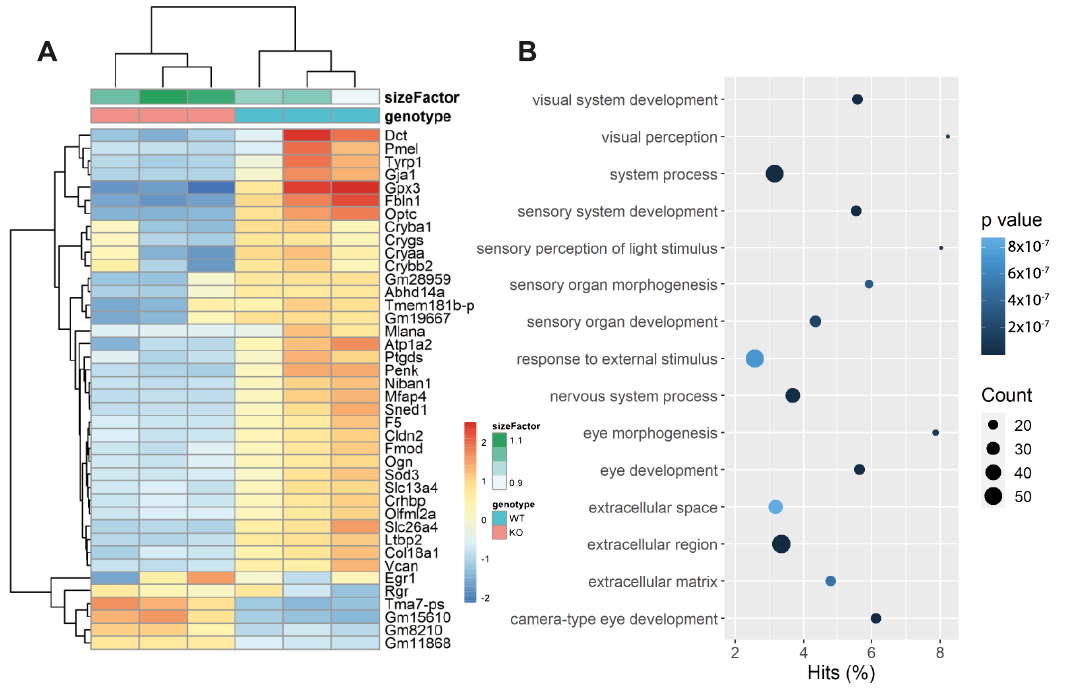
Figure 11. RNA-seq data analysis of WT and Faim KO retinas exposed to 24 h LD. ( A ) Heatmap of RNA-sequencing expression data showing the top genes that are differentially regulated following light damage (LD, 10,000 lux for 24 h) in Faim KO (KO) and WT mice at two – three months of age. ( B ) Top 15 GO terms enriched in Faim KO mice. Dot size represents the number of genes in the GO term, and color represents the p value.